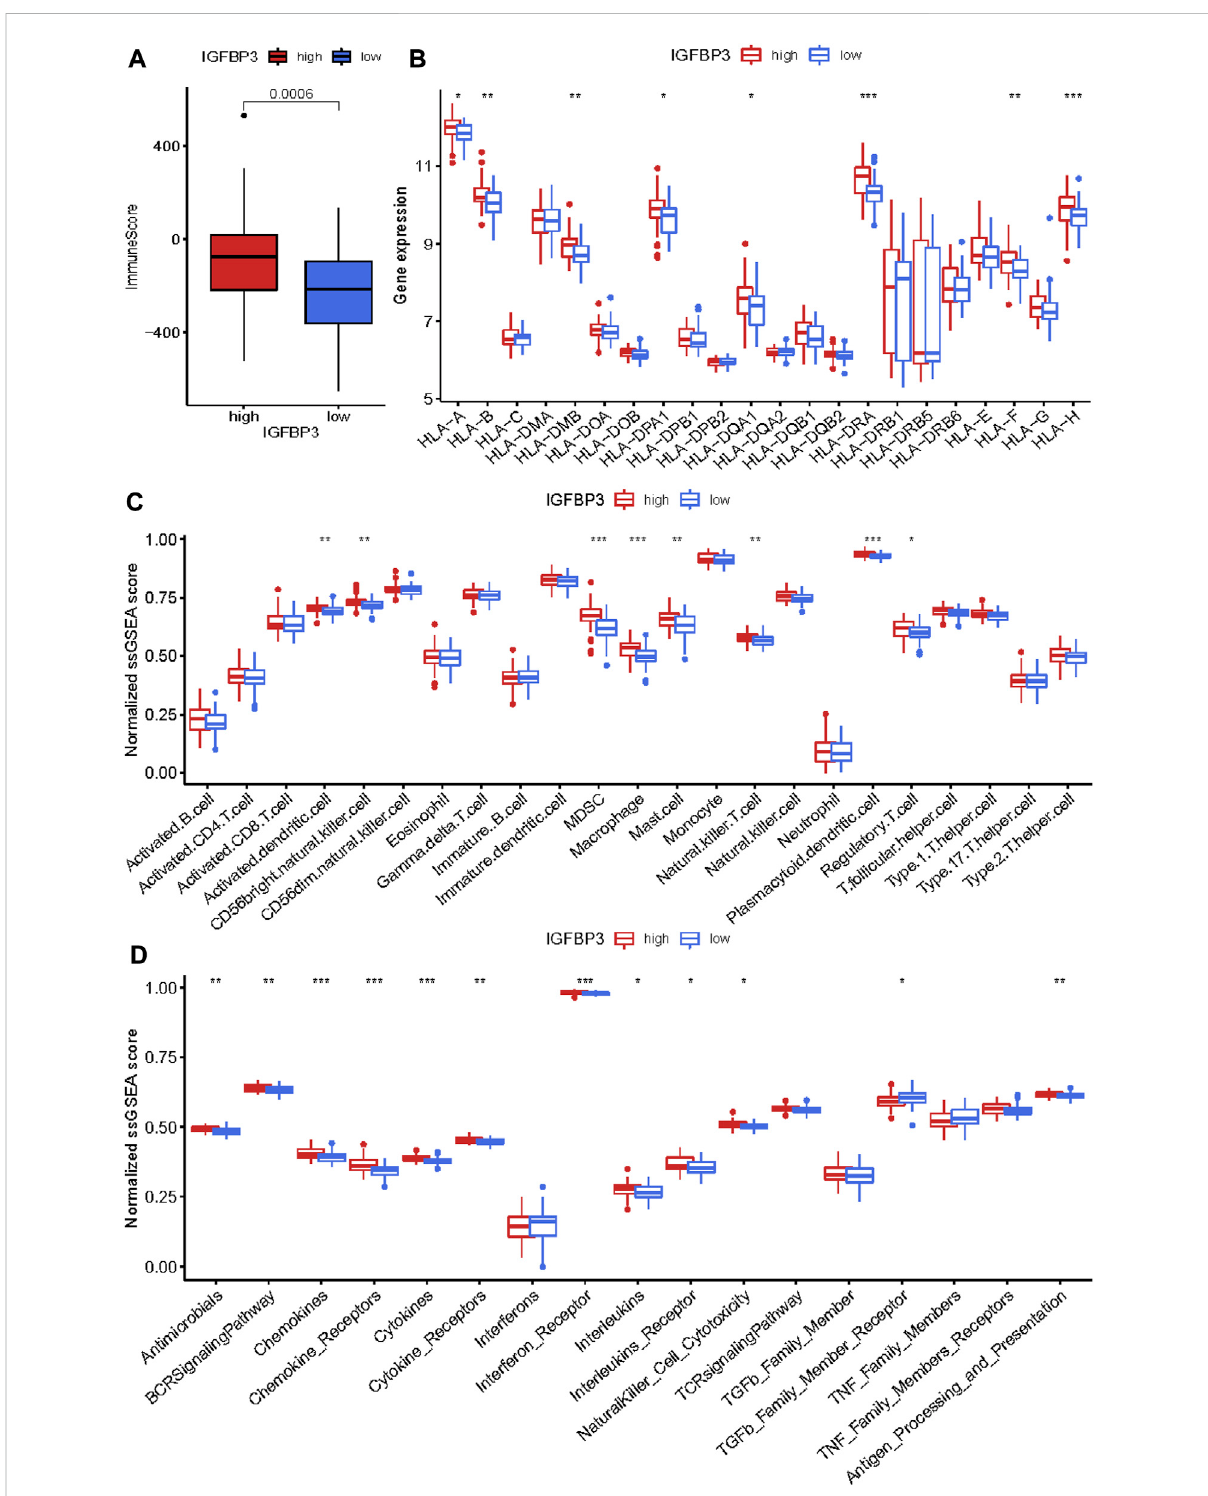
FIGURE 5 Immune in fi ltration difference between the two m6A subgroups based on IGFBP3 expression using Wilcox rank sum test. (A) Different immune scores between the two subgroups. (B) Different expression of human leukocyte antigen (HLA) genes. (C) Difference in the abundance of immune cells between the two subgroups. (D) Difference in the activation of immune responses. * p < 0.05, ** p < 0.01, *** p <